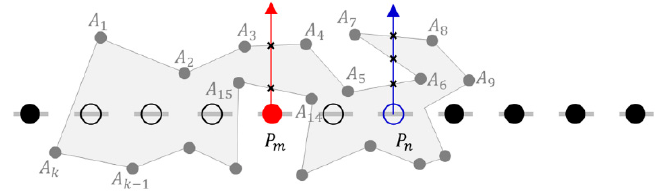
Figure A1. An example of the ray casting algorithm.